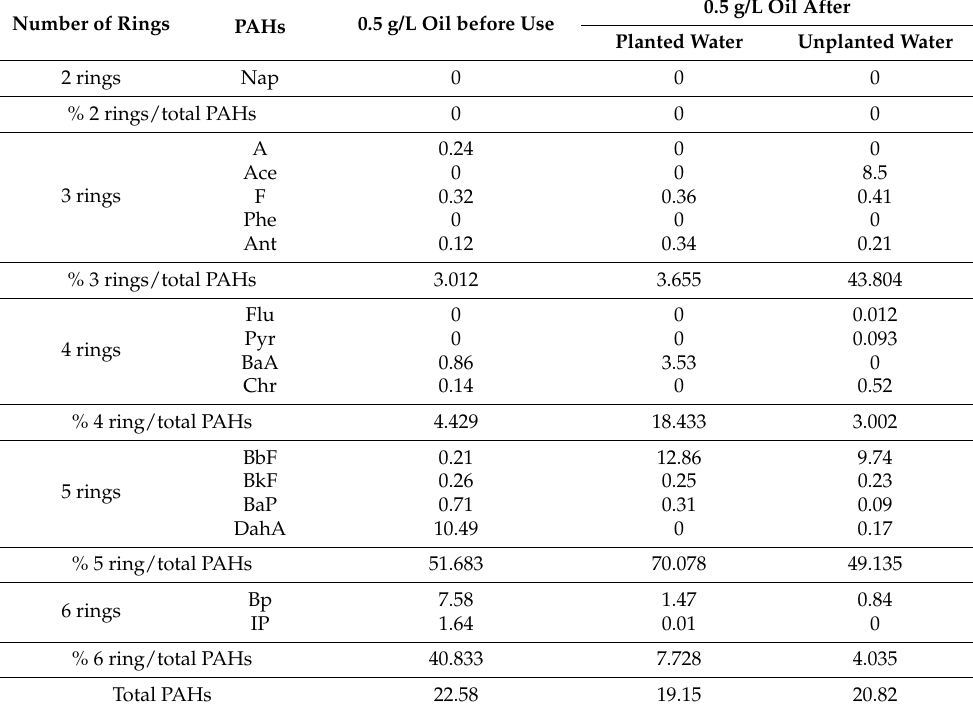
Table 3. Quantitative HPLC analysis of PAHs (mg/L) of 0.5 g crude oil before the experiment and those extracted from the 0.5 g/L crude oil–polluted control and planted treatment with the A-A com- bination after a 7-day growth period. Nap = naphthalene, A = acenaphthylene, Ace = acenaphthene, F = fluorene, Phe = phenanthrene, Ant = anthracene, Flu = fluoranthene, Pyr = Pyrene, BaA = benzo (a) anthracene, BaP = benzo (a) pyrene, BbF = benzo (b) fluoranthene, BkF = benzo (k)